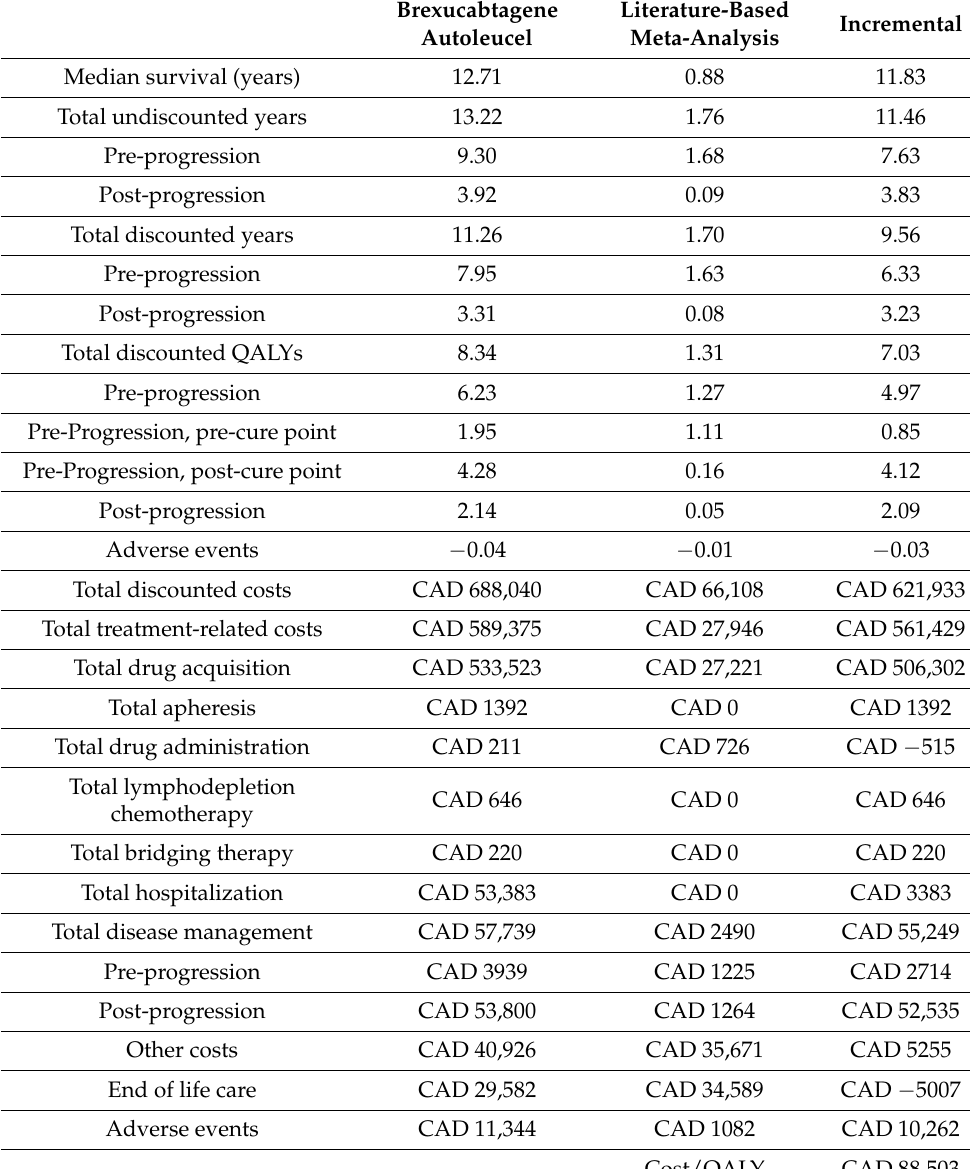
Table 4. Disaggregated deterministic results of brexucabtagene autoleucel vs.